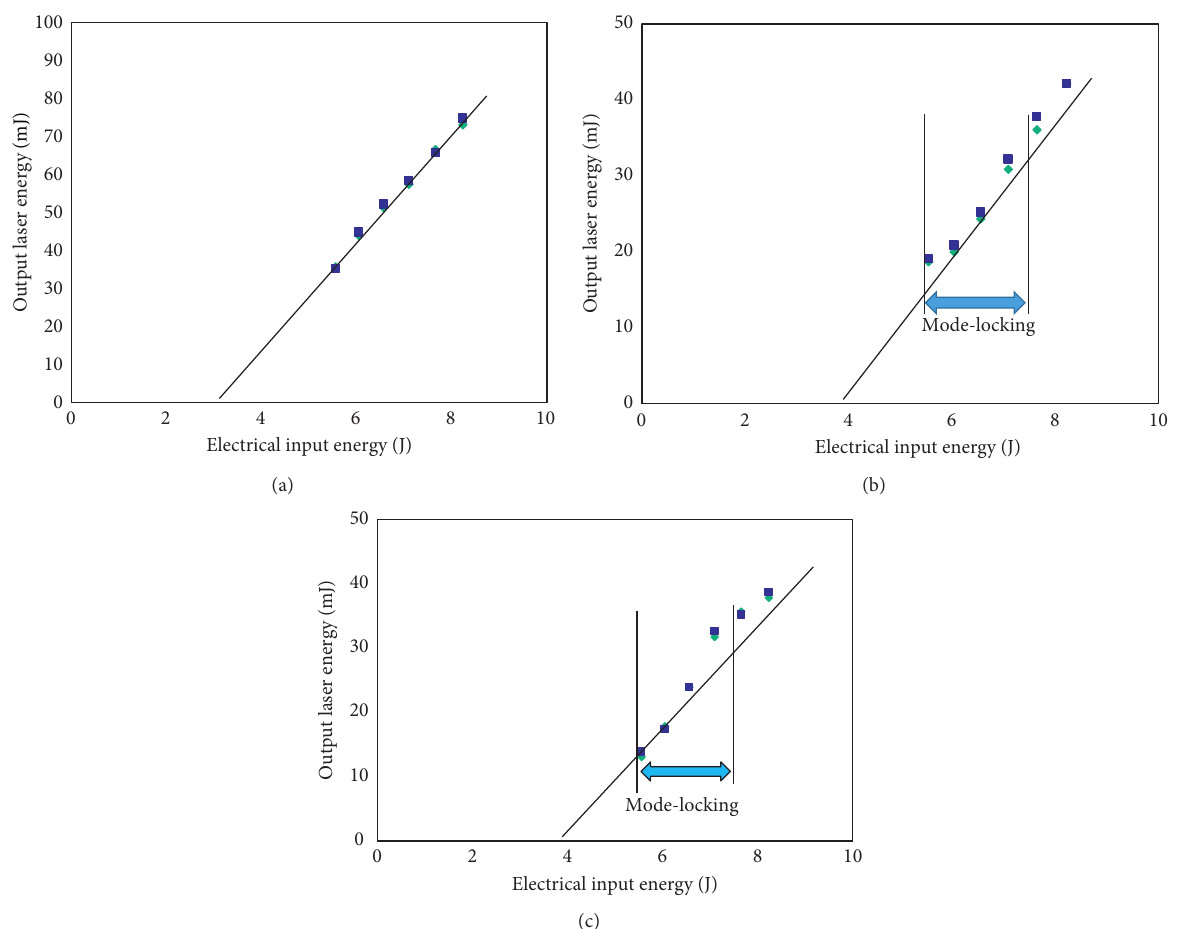
Figure 9: Measured output laser energy: (a) free-running mode; (b) Cr 4+ :YAG T � 90%; (c) Cr 4+ :YAG T � 95%.